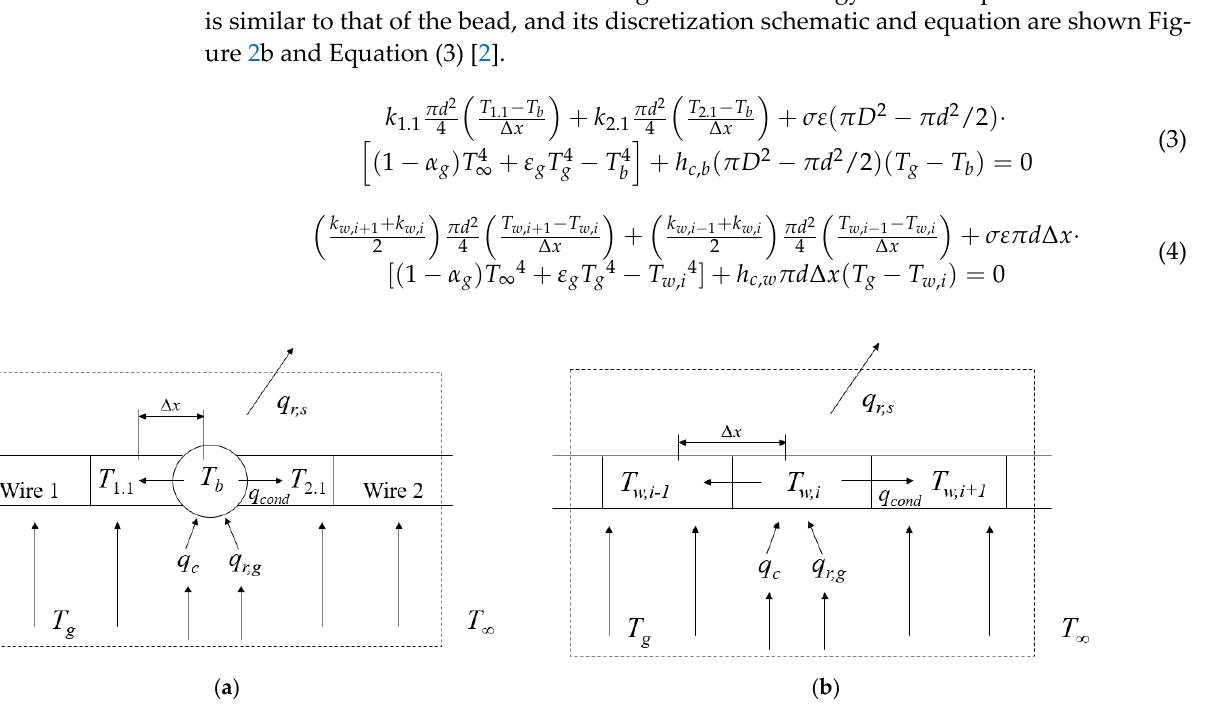
Figure 2. Schematic of bead and wire energy balance discretization. ( a ) Thermocouple bead; ( b ) Thermocouple wire. ( b ) Thermocouple